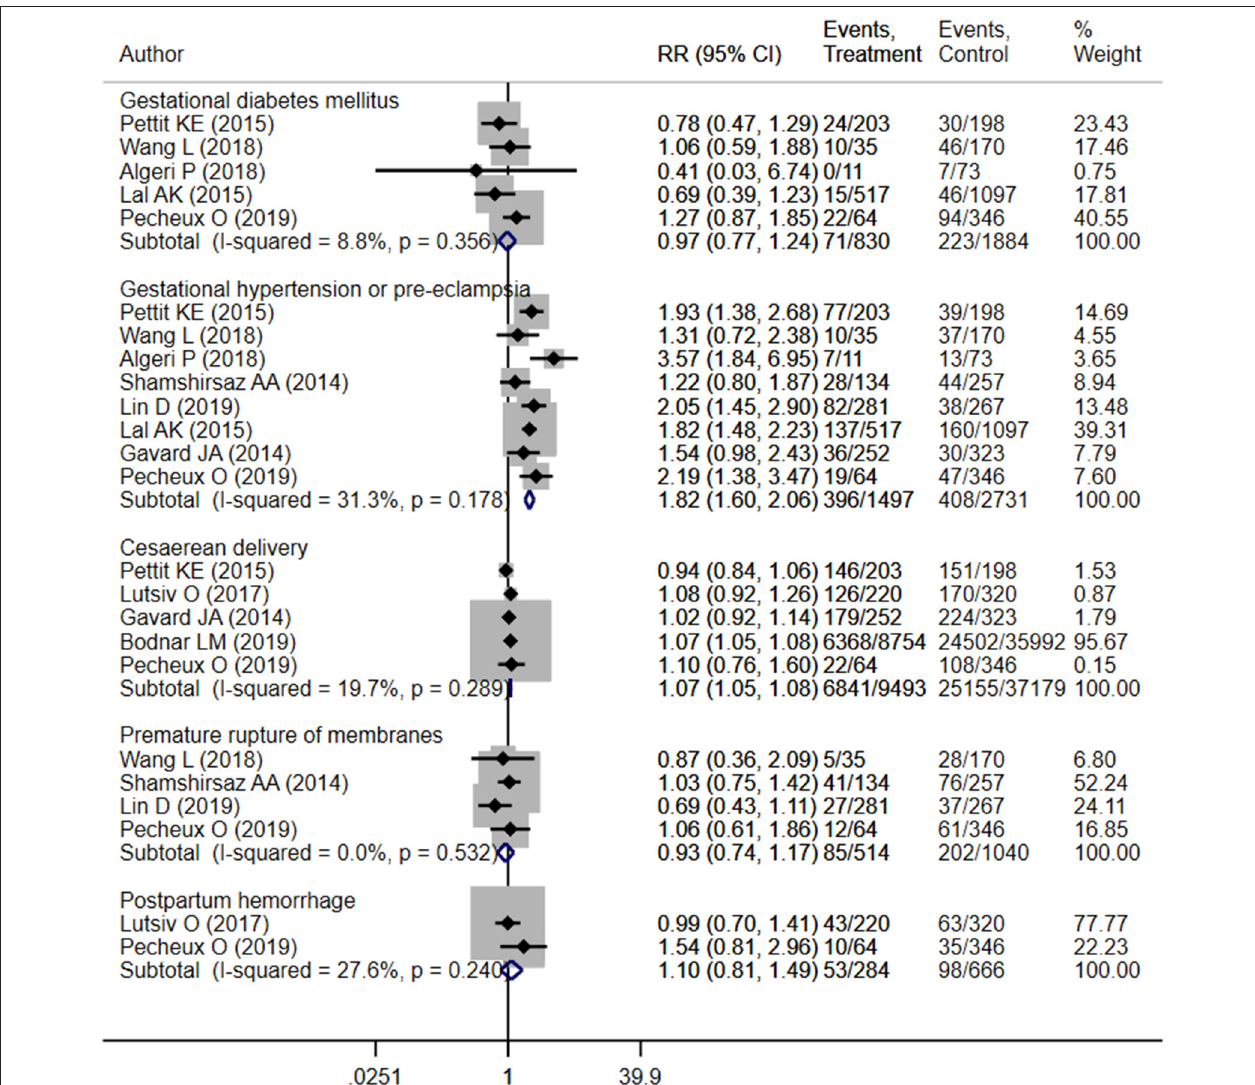
FIGURE 6 | Pooled analysis of excessive or adequate pregnancy weight gain effects on maternal health outcomes.